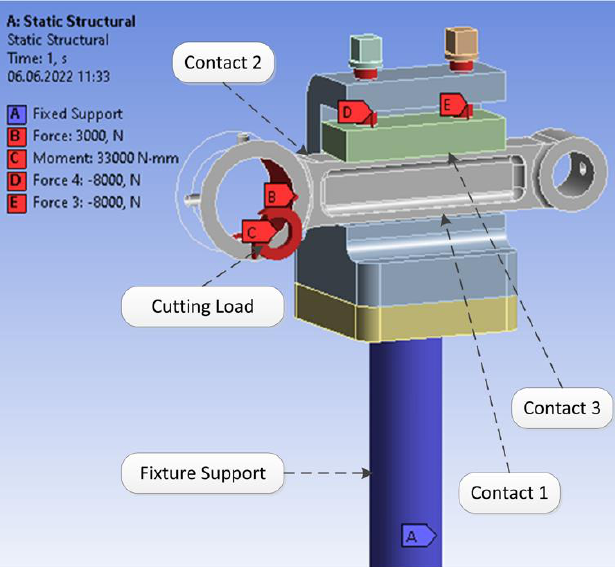
Figure 4. Boundary conditions and contact layers for the fixture.